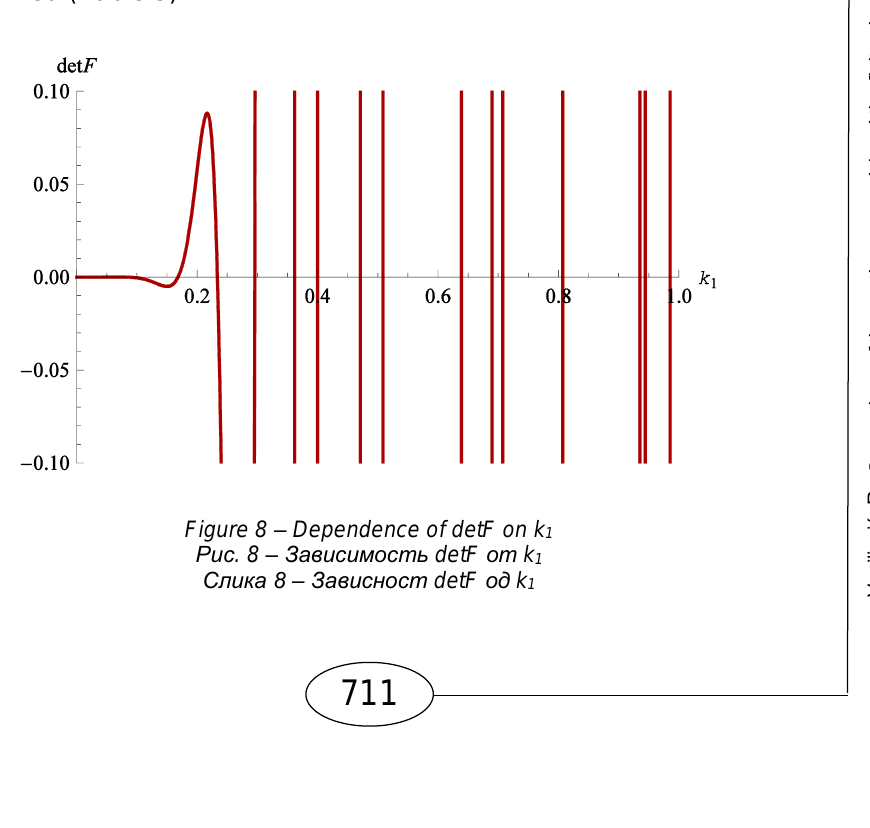
Figure 8 – Dependence of detF on k 1 Рис. 8 – Зависимость detF от k 1 Слика 8 – Зависност detF од k